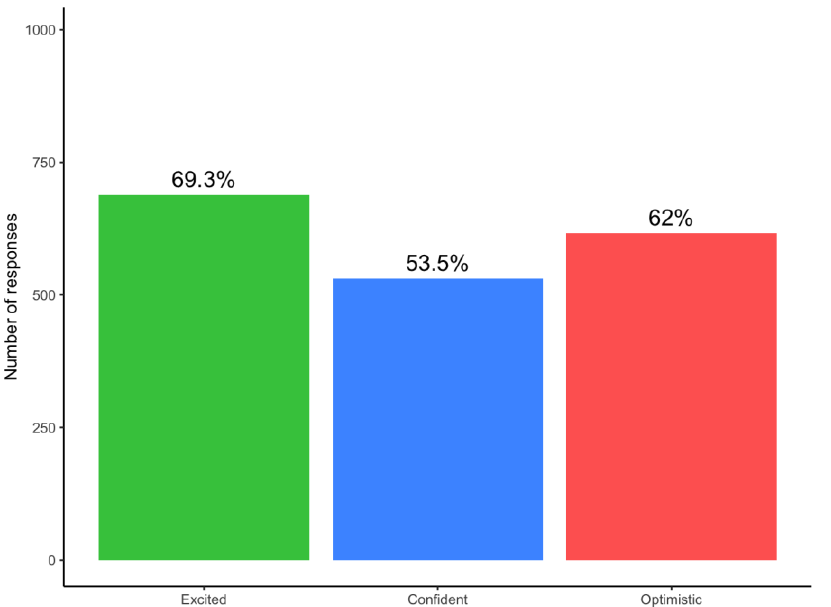
Figure 2. Negative emotions expressed (i.e., strongly agree or agree) by 374 of the 993 participants in the BREATHE study recruited between October 2021 and March 2022.